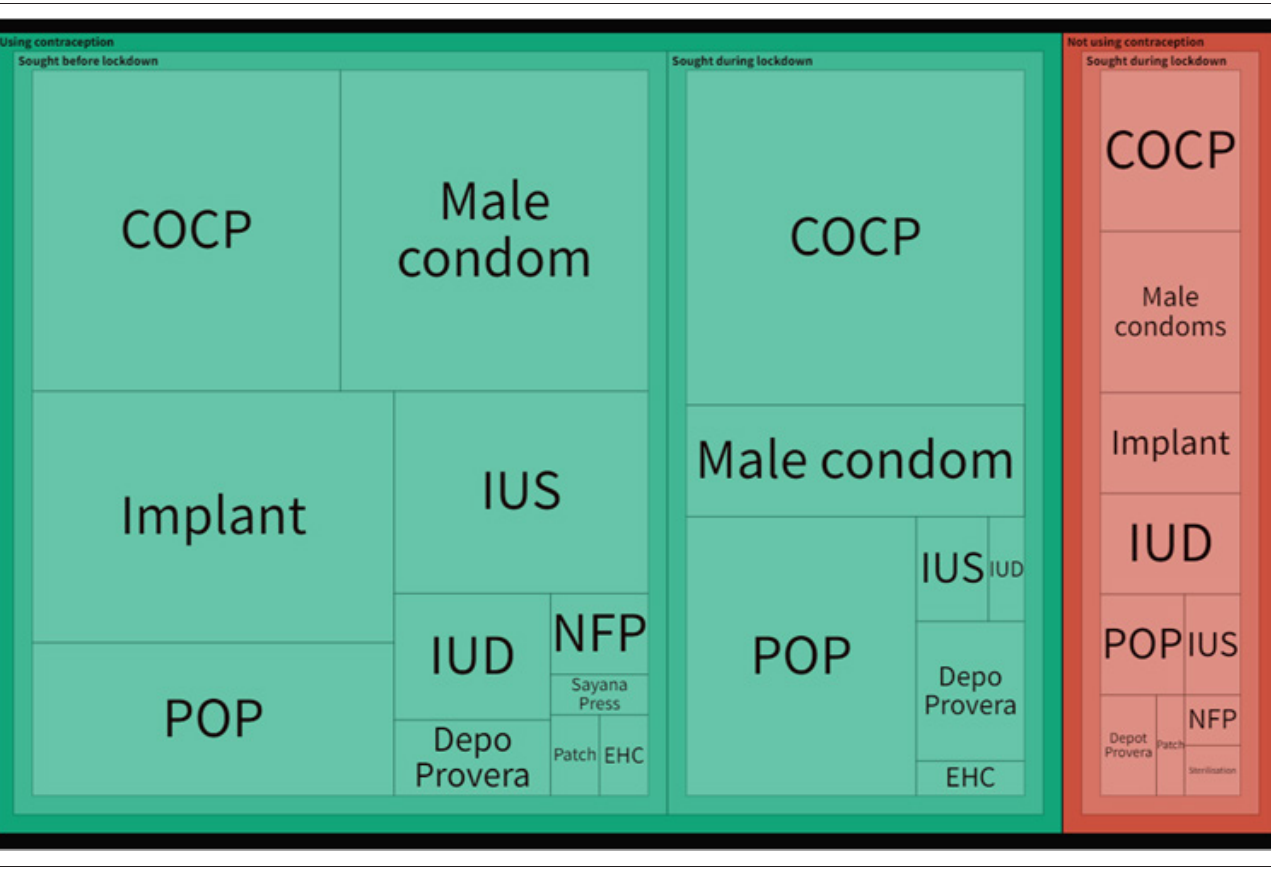
Ma R et al . BJGP Open 2022; DOI: 10.3399/BJGPO.2021.0218